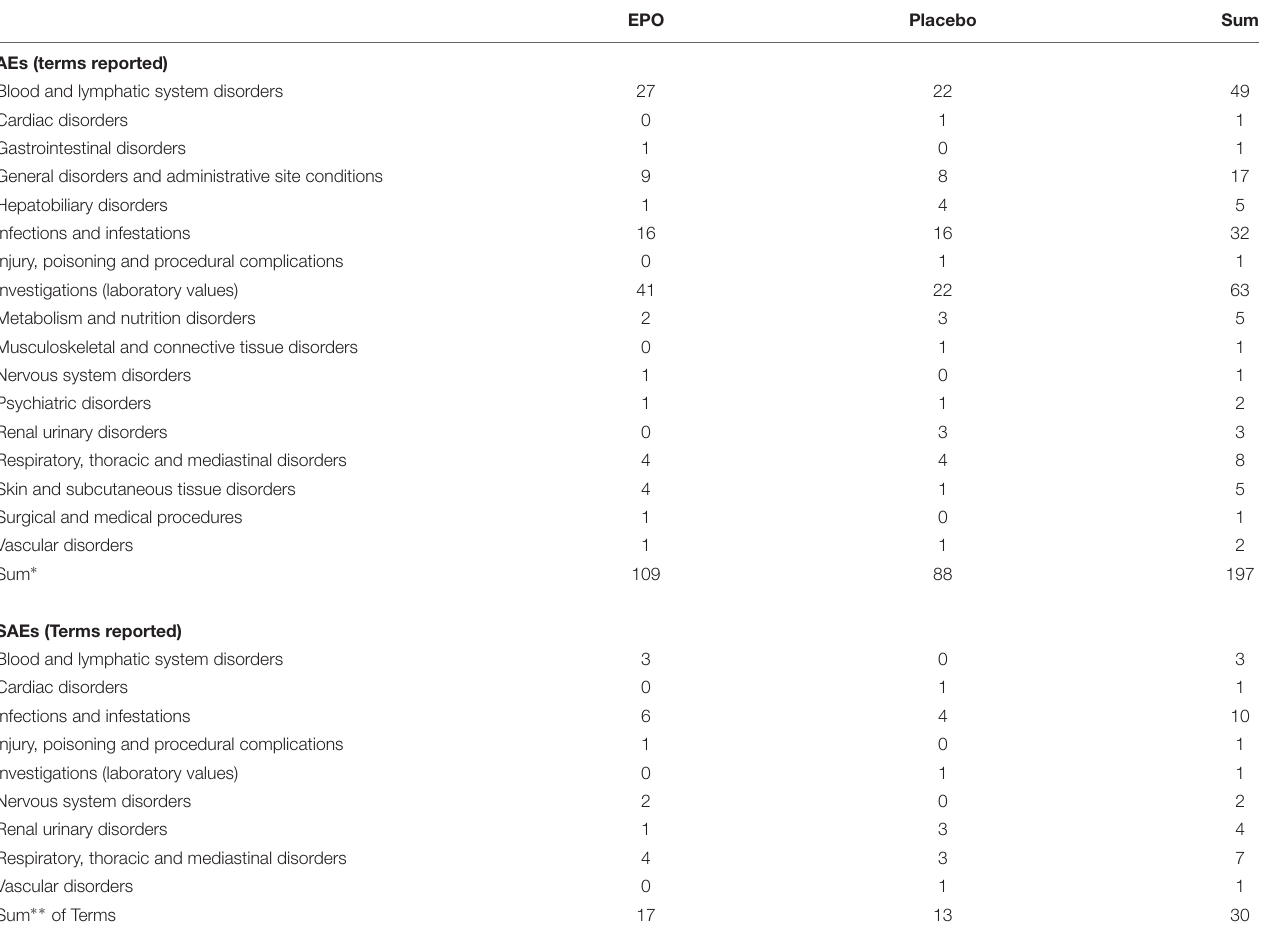
TABLE 8 | Adverse events and severe adverse events.